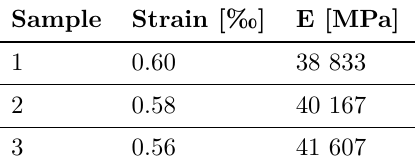
Table 1. Results of the bending test at the glass canopy specimens [11].